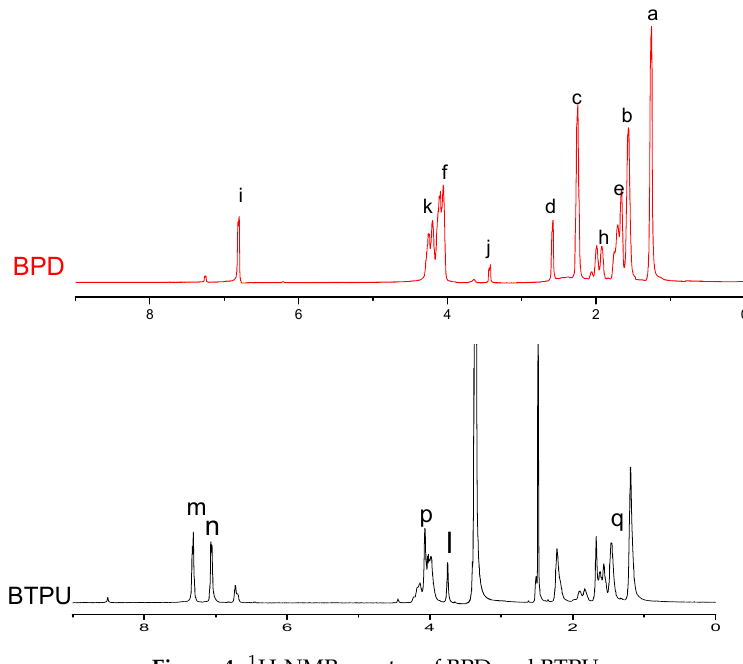
Figure 4. 1 H-NMR spectra of BPD and BTPU.